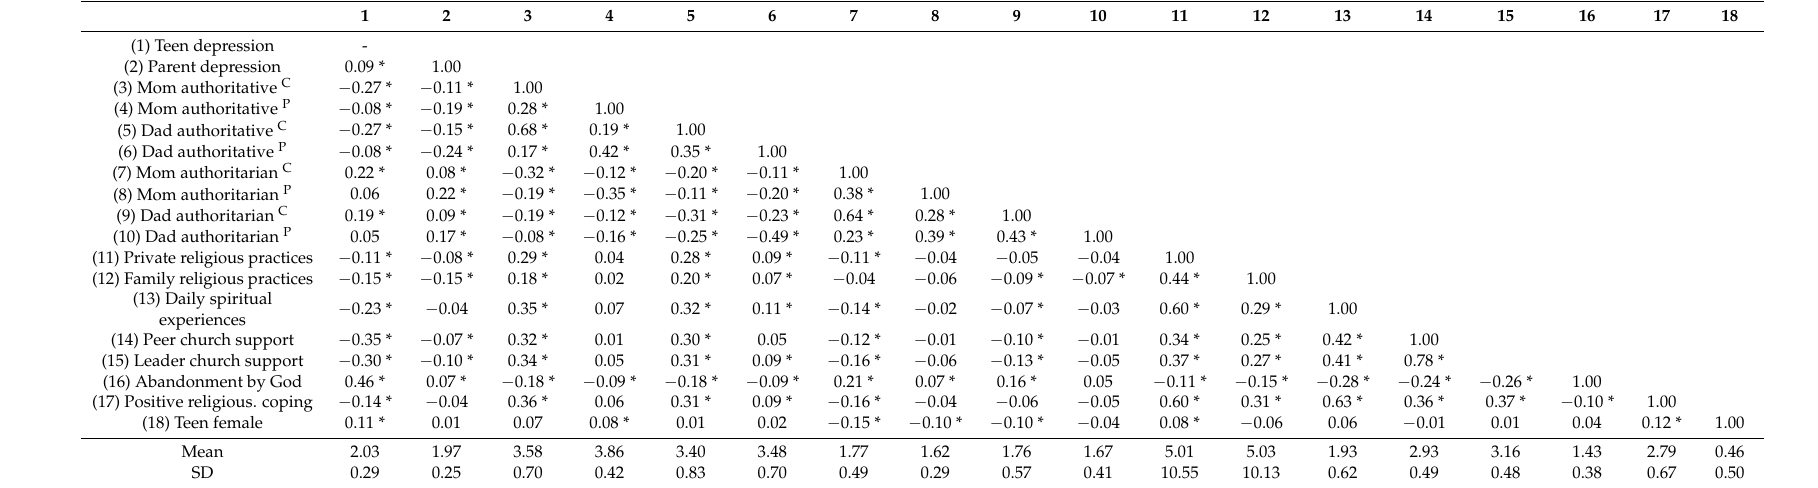
Table 1. Correlations and descriptives ( n =